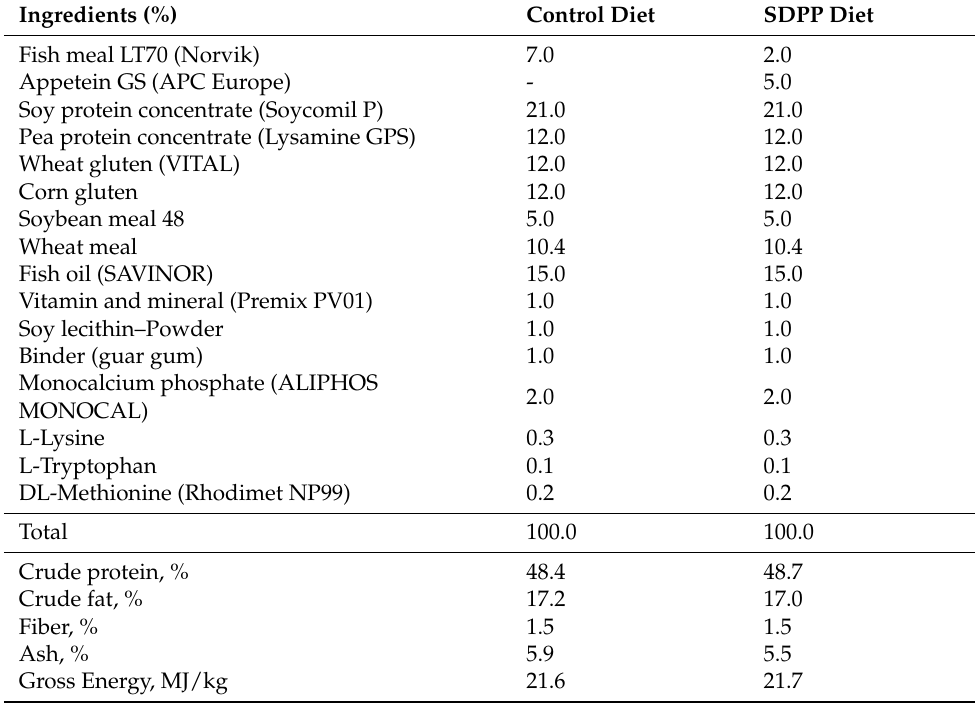
Table 1. List of ingredients and proximal composition of experimental diets used for evaluating the nutritional and functional properties of spray-dried porcine plasma (SDPP) on gilthead sea bream ( Sparus aurata )